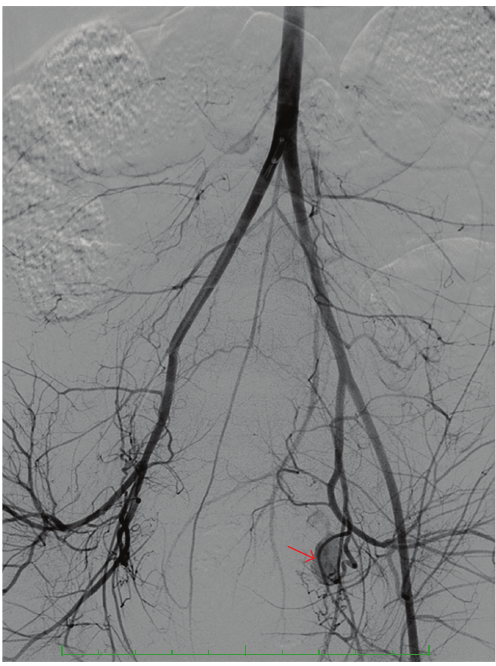
Figure 1: The subtracted aortogram image demonstrates general- ized arterial spasm, spasm of the right common femoral artery, and a left uterine artery pseudoaneurysm (arrow).